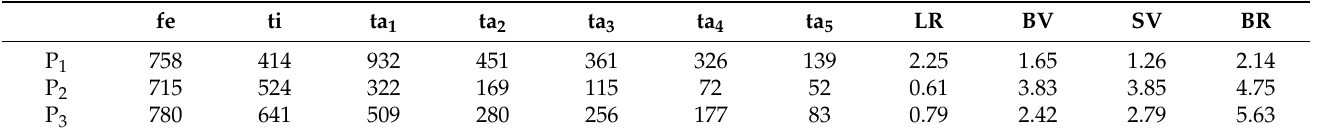
Table 2. Lengths (in µ m) and proportions of legs of Rheotanytarsus ferringtoni Lin & Yao sp. n. , adult male ( n =